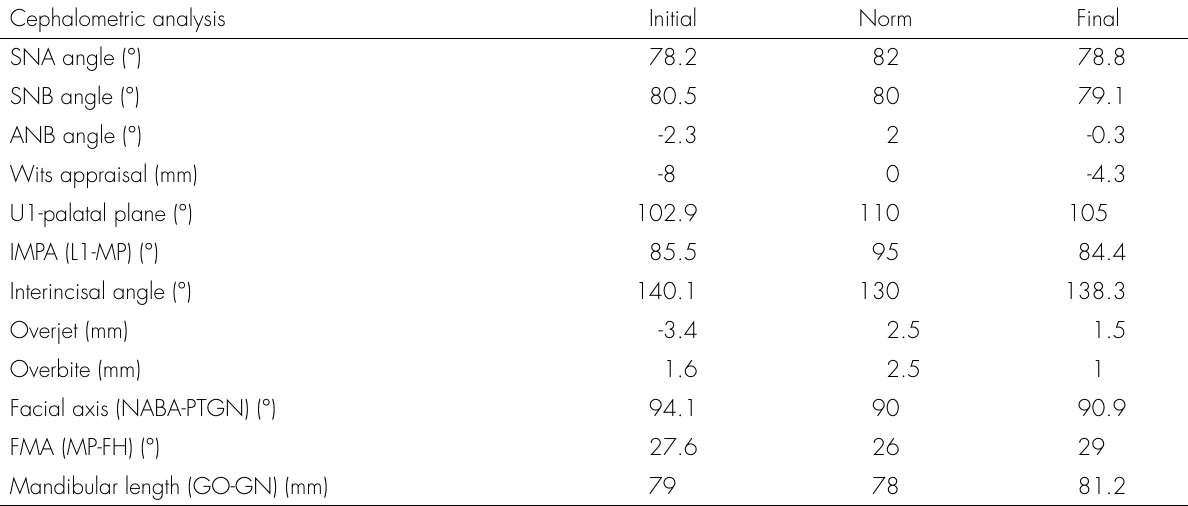
Table I. Pretreatment and post-treatment cephalometric measurements.